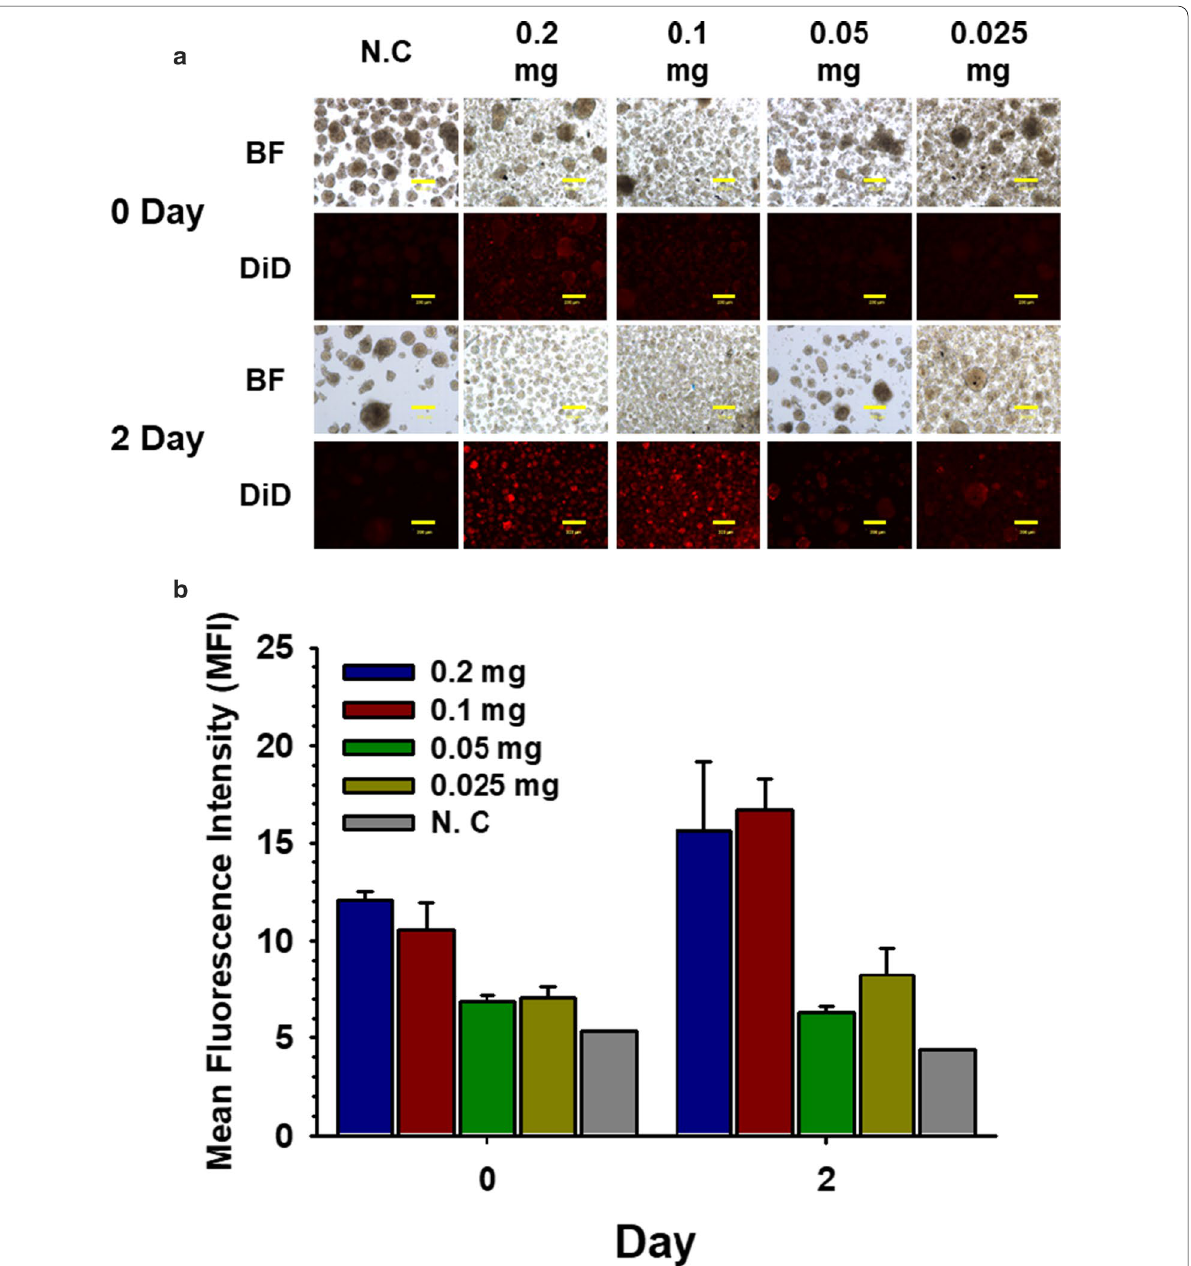
Fig. 1 Optimization of PSome concentration for effective nano‑encapsulation at 0 and 2 days. Optimization of PSome concentration for